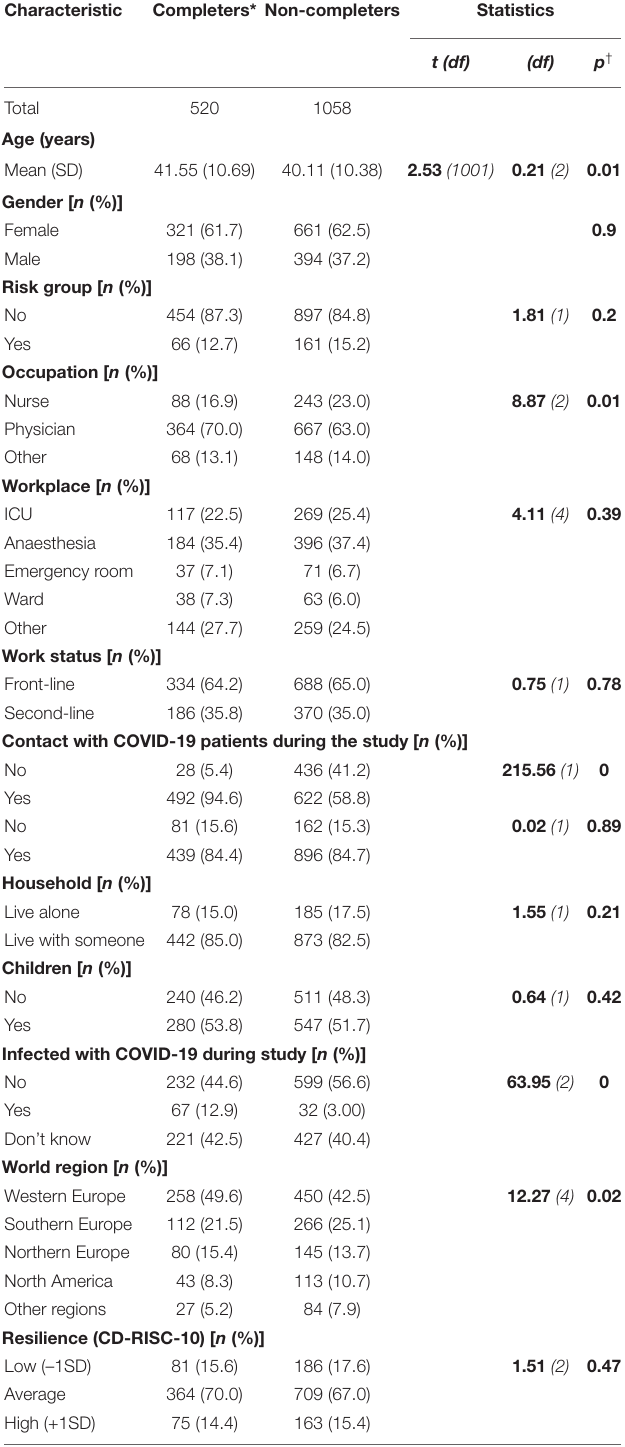
TABLE 1 | Characteristics of the healthcare professionals included in this